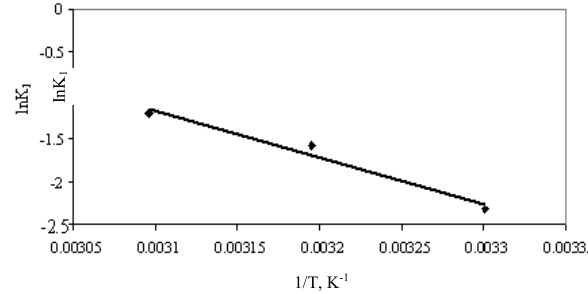
Figure 10. The variation of the Langmuir constant with temperature.